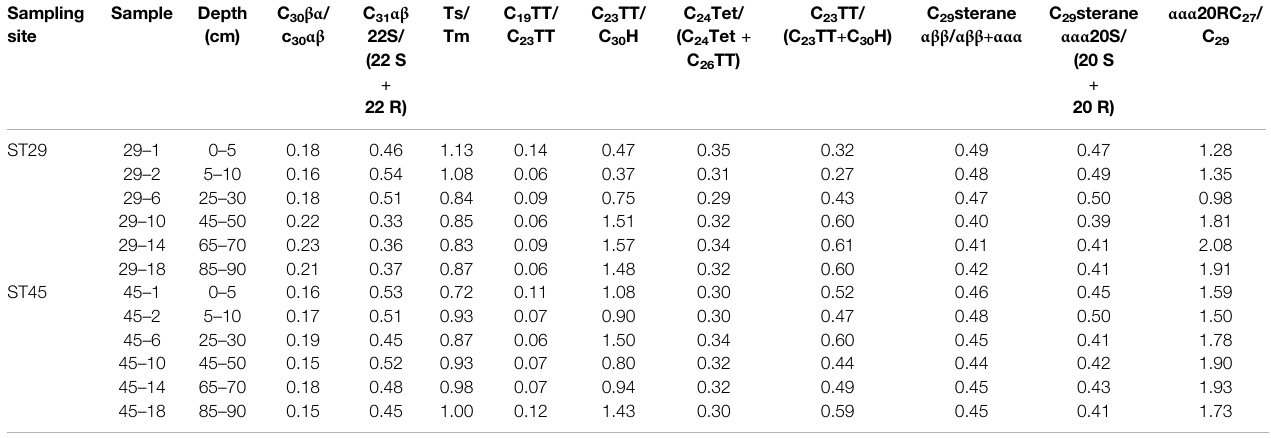
TABLE 3 | Terpane and sterane parameters for core sediments.